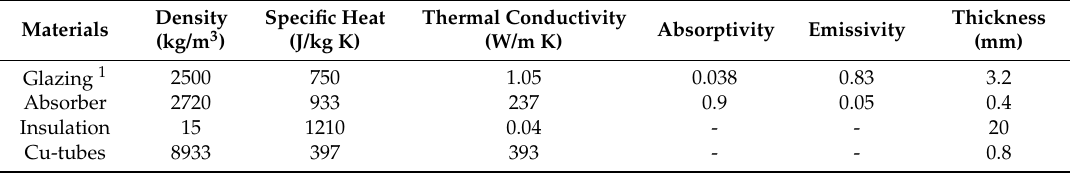
Figure 1. Schematic diagram of the dual-function solar collector. Table 1. Parameters characteristic of the collector.